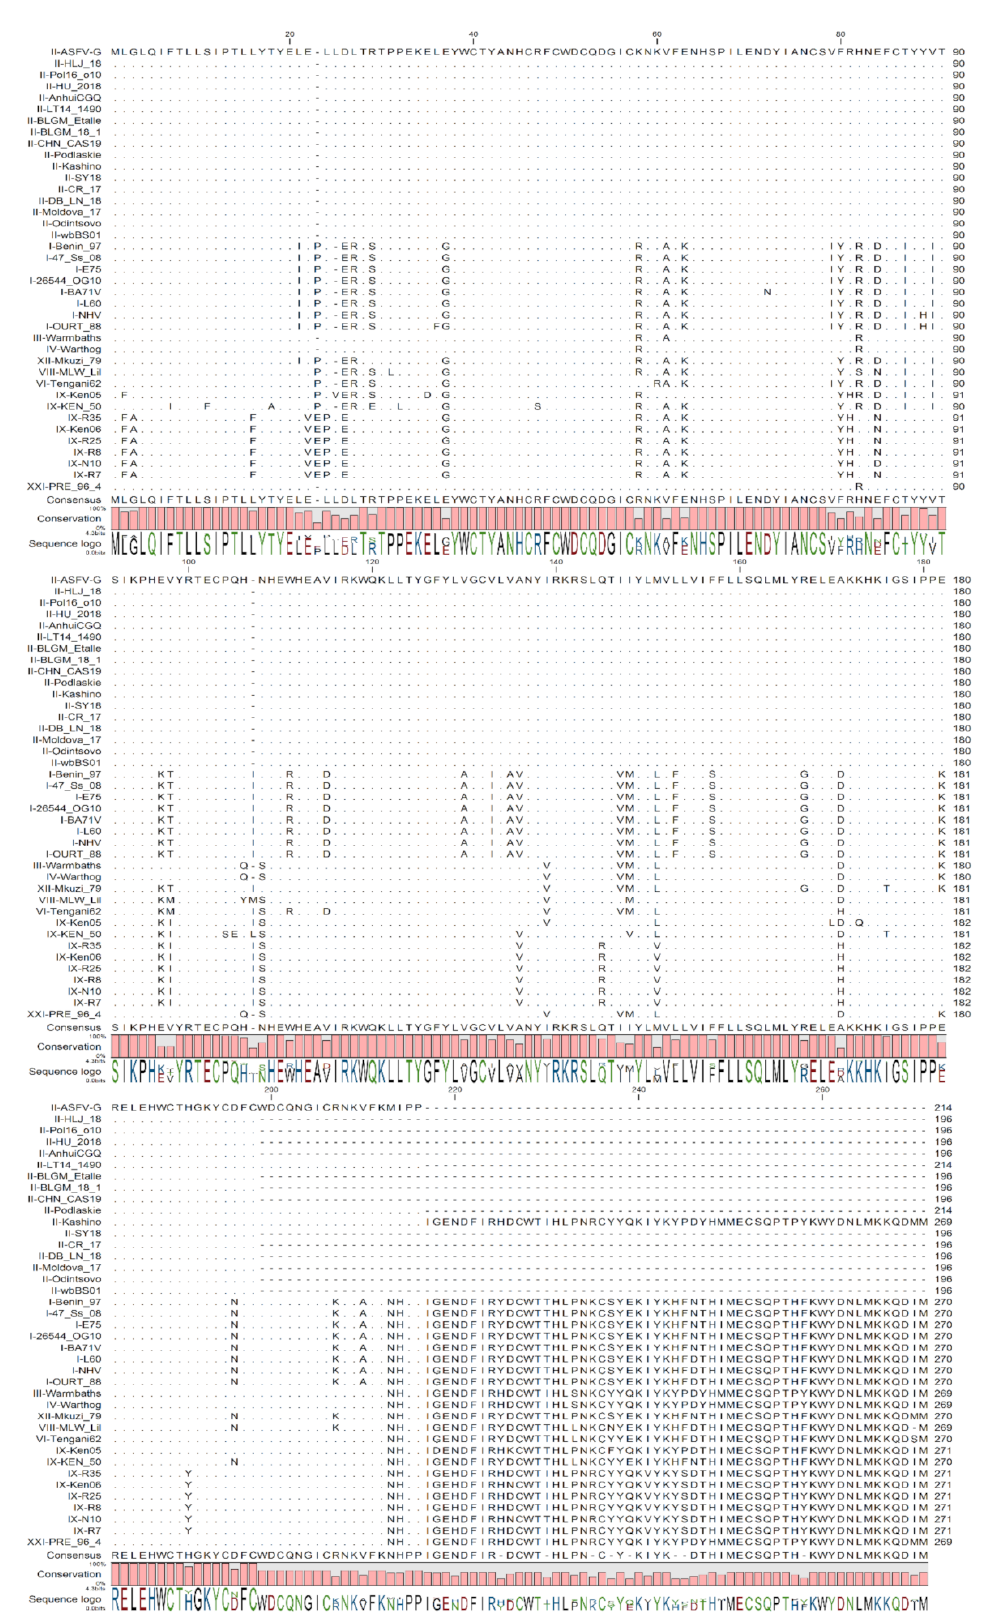
Figure 2. Multiple sequence alignment of the indicated African swine fever virus (ASFV) isolates of viral protein MGF110-1L. Matching residues are represented as dots. The degree of conservation is below the